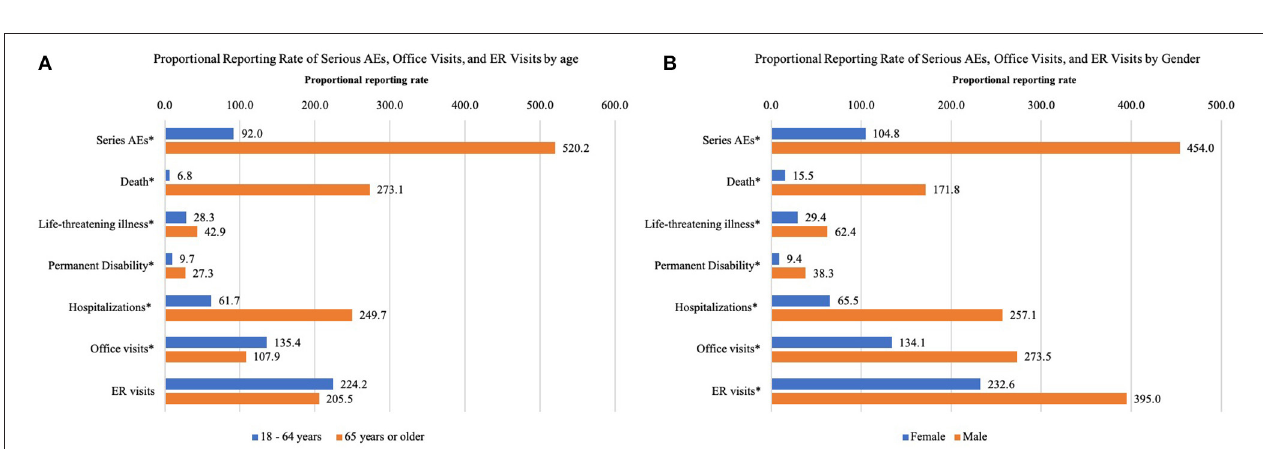
FIGURE 2 | The proportional reporting rate per 1,000 people of serious AEs, office visits, and ER visits by (A) age, and (B) gender among adults who had AEs following COVID-19 vaccination. Hospitalizations include hospitalization and existing hospitalization prolonged. ER, Emergency room. *Significant at 0.05 confidence